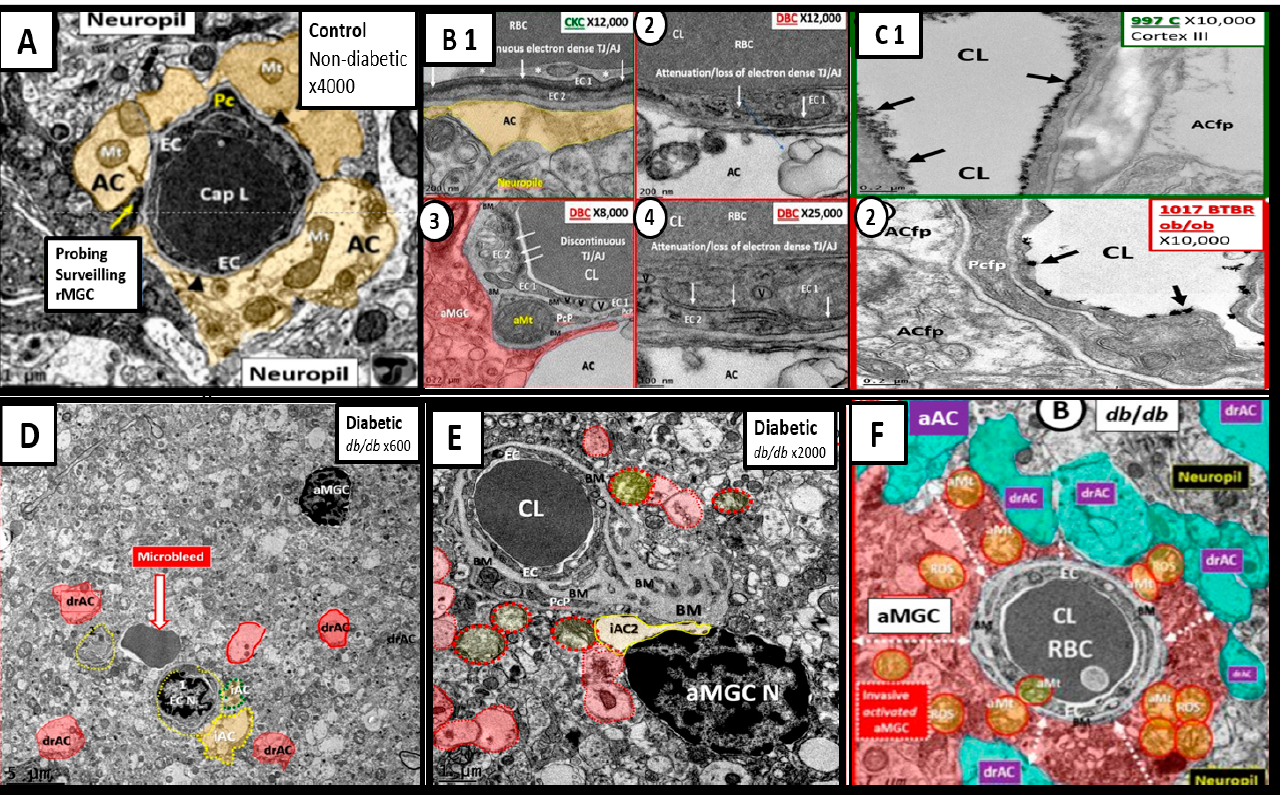
Figure 6. Compilation of Abnormal Remodeling in the Cortical Grey Matter Layer III in Diabetic db/db and BTBR ob/ob Neurovascular Unit (NVU). Panel ( A ) is the control model and depicts the normal morphology of the NVU and the remainder of images are compiled from the diabetic db/db and BTBR ob/ob models. Panel ( B1 ) (control with intact blood-brain barrier (BBB)) and ( 2 – 4 ) depicts the attenuation and or loss of the endothelial cell (EC) tight and adherens junctions (TJ/AJ) of the BBB. Panel ( C1 ) depicts the highly electron dense endothelial glycocalyx (arrows) found in non-diabetic control models while Panel ( 2 ) depicts the attenuation and/or loss of the endothelial glycocalyx (arrows) by lanthanum nitrate perfusion fixation staining in the BTBR ob/ob diabetic model. Panel ( D ) depicts astrocyte foot process detachments from the endothelial neurovascular unit (NVU) with a nearby activated microglial cell (aMGC) and a labeled microbleed adjacent to the NVU in this low magnification image. Panel ( E ) depicts marked basement membrane thickening that is associated with the capillary NVU and note the detached astrocyte foot processes (ACfp) pseudo-colored red and the aMGC. Panel ( F ) depicts an aMGC (pseudo-colored red) that is encompassing the capillary NUV and note again the detached and retracted ACfp (drAC) (pseudo-colored cyan) with magnification ×2500 (not shown). These images display the remodeling changes that accompany the uncoupling of the NVU in brain grey matter in cortical layers III. Images in this compilation figure were modified with permission by CC 4.0 [27,32].